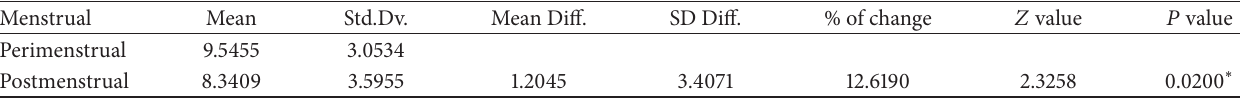
Table 1: Comparison of perimenstrual and postmenstrual DAS scores by Wilcoxon matched pairs test by ranks. Menstrual